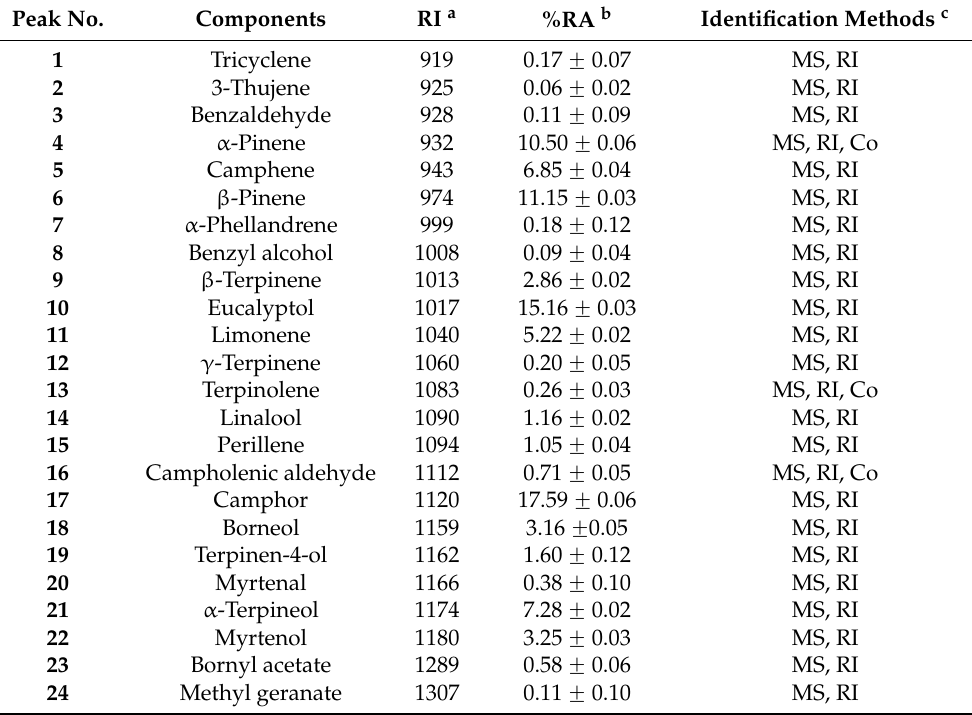
Table 1. Chemical components of the essential oil from A. kwangsiensis . Peak